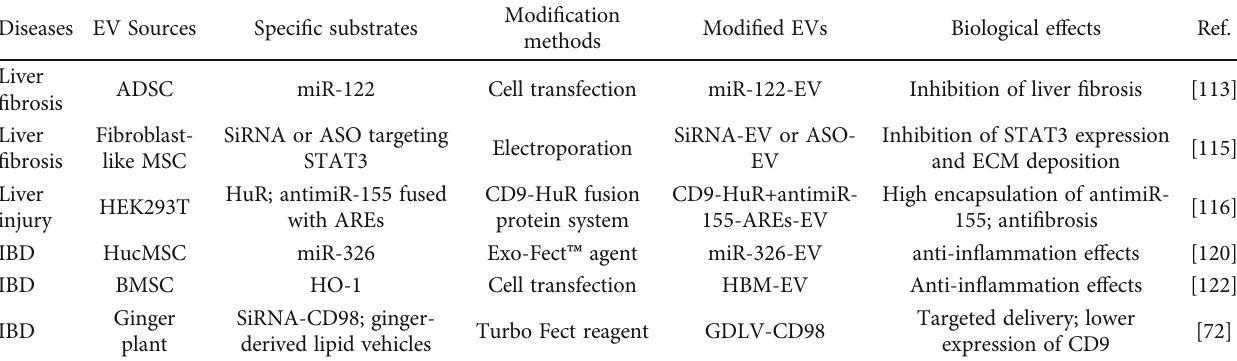
Table 5: Modi fi ed EVs in the therapy of digestive